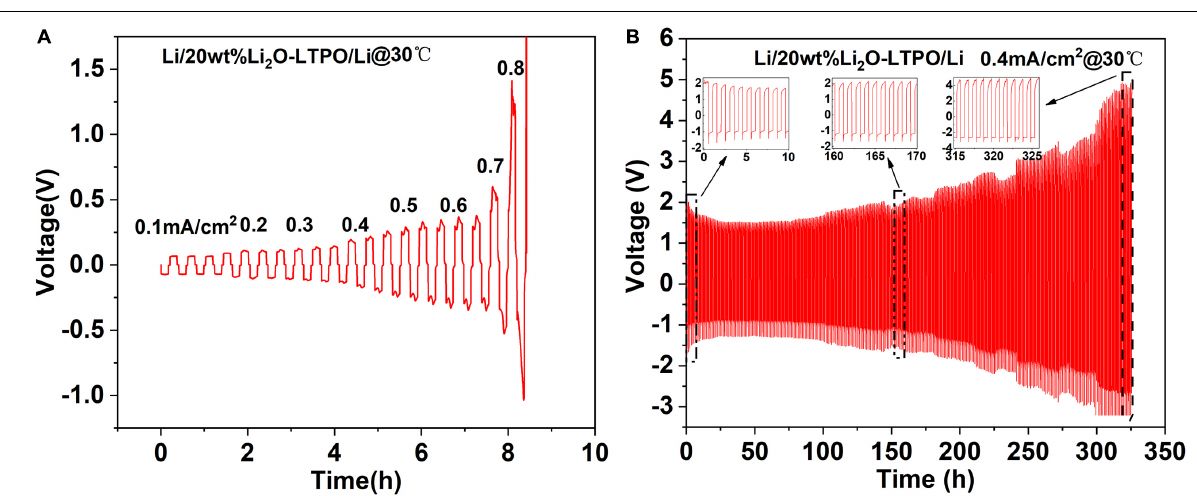
was tested under different charge and discharge current